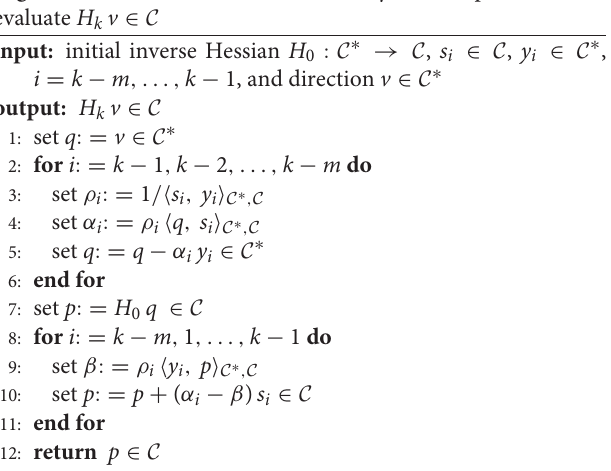
Algorithm 2 Inverse Limited-Memory BFGS procedure